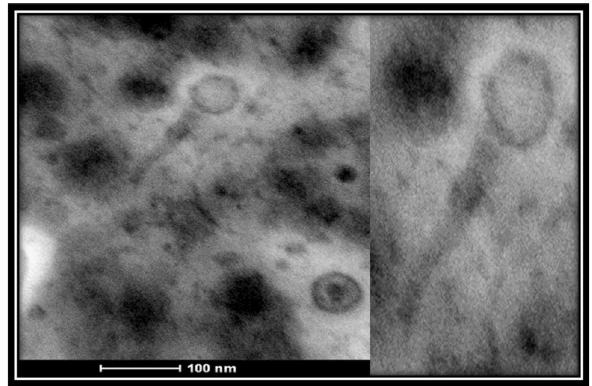
Figure 2. Transmission Electron Micrograph of Salmonella phage BIS20. Phage was stained with 1% uranyl acetate solution images were taken at an acceleration voltage of 80 kV. Scale bar represents 100 nm.